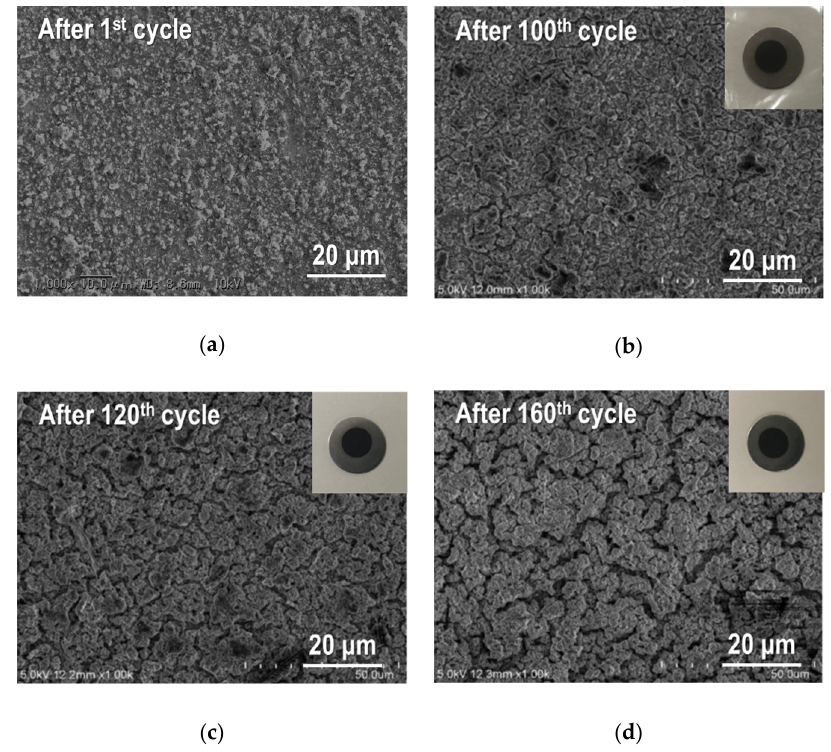
Figure 9. SEM images for the broader surface of Sn 4 P 3 /C composite films taken out of disassembled cells: ( a ) after the first cycle, ( b ) after the 100th cycle, ( c ) after the 120th cycle and ( d ) after the 160th cycle. Insets in ( b ), ( c ) and ( d ) are the photo images of films with different cycle numbers.